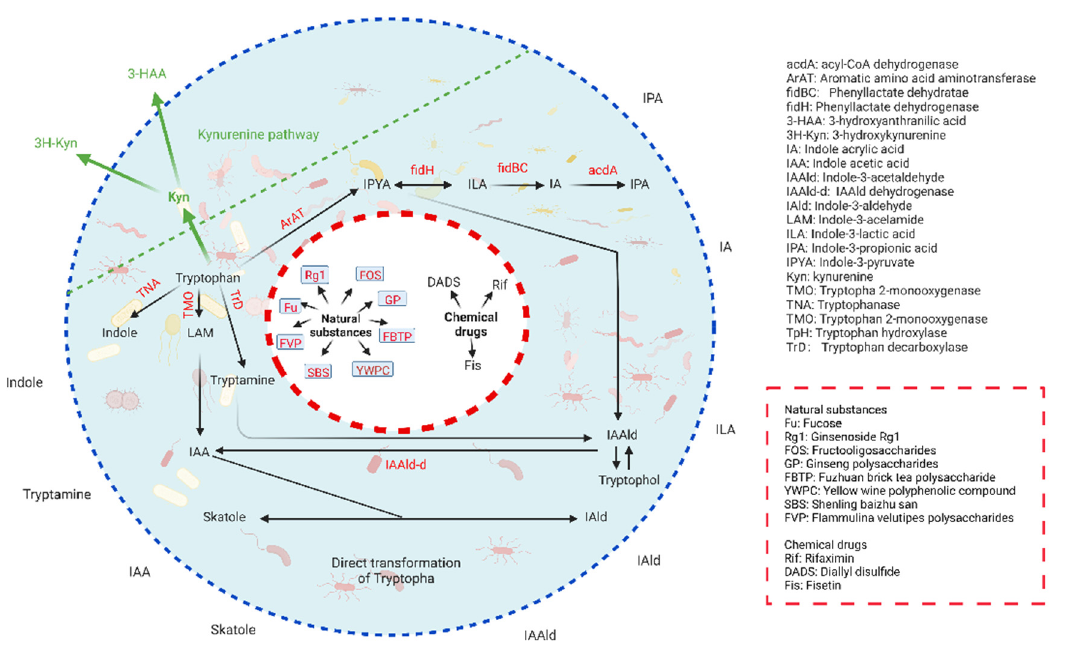
Figure 1. Production and regulation of Trp metabolites in the gut microbiota. Trp is an essential amino acid, which can be naturally provided by dietary proteins. Trp metabolism in the gut micro- biota follows two major pathways: (1) Direct transformation. Trp is converted into various catabo- lites by the gut microbiota, such as indole, IAA, IPA, IA, IAld, tryptamine, IE, IAAld and Skatole. (2) Kynurenine pathway. Trp is catalyzed to produce Kyn and downstream metabolites such as 3-HAA and 3H-Kyn. There are some factors, including natural substances and chemical drugs inside the circle (red dotted line), which can regulate tryptophan metabolism in the gut microbiota. Words in red are a key enzyme. Background, gut microbiota. Table 1. Gut microbiota species and Trp metabolites.